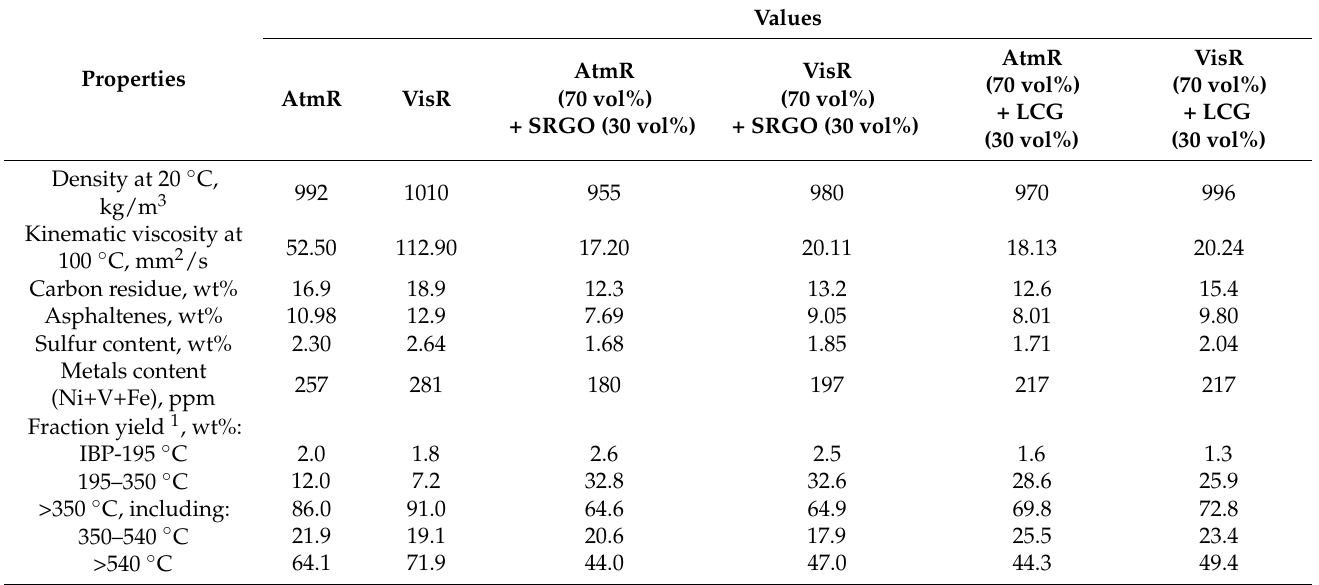
Table 2. Characteristics of the feed for adsorptive